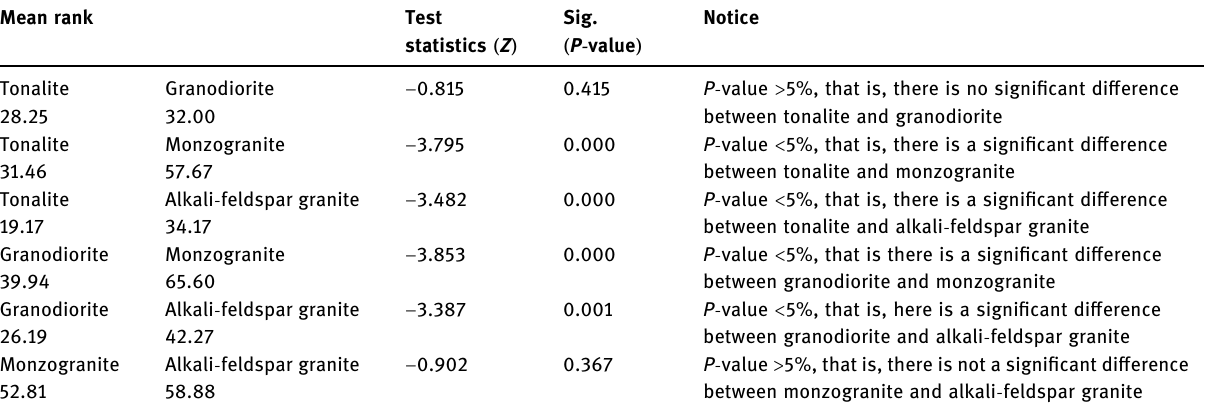
Table 6: Pearson correlation among ( tonalite, granodiorite, monzogranite, and alkali - feldspar granite ) Sig ( 2 - tailed ) Tonalite Granodiorite Monzogranite Alkali - feldspar granite Tonalite 1 0.603** − 0.752** 0.573** Granodiorite 0.603** 1 − 0.485** 0.723** Monzogranite 0.752** − 0.485** 1 − 0.**598 Alkali feldspar granite 0.573** 0.723** − 0.598**